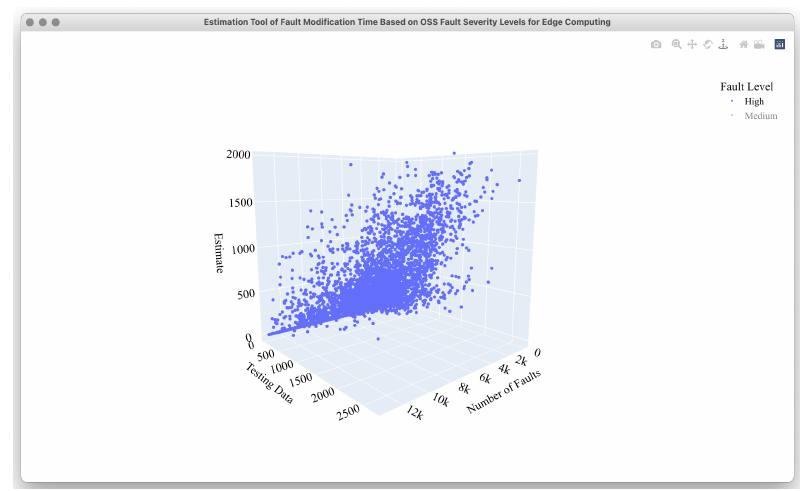
Figure 15. The estimated fault correction time in case of high-level 30% testing data.